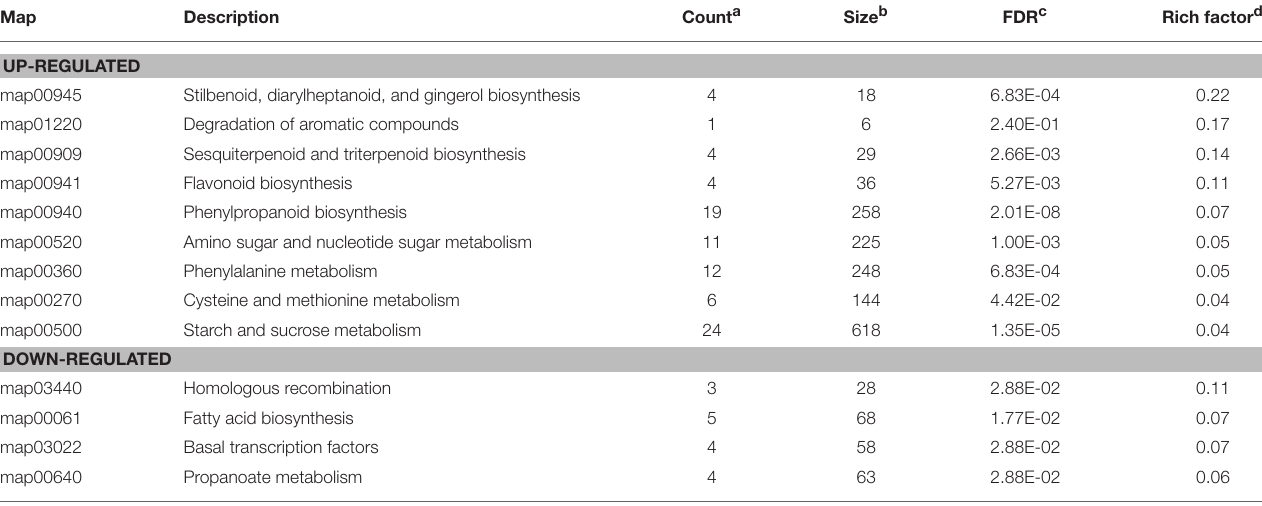
TABLE 5 | KEGG pathway enrichment of differentially expressed genes in Mol vs. Gal.